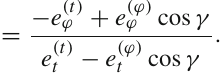
Fig. 10 The left panel shows the restriction on the values of λ and the function λ c . The middle panel shows the effective potentials L r and L θ , and the minimum of L r ; the right panel shows the allowed values of